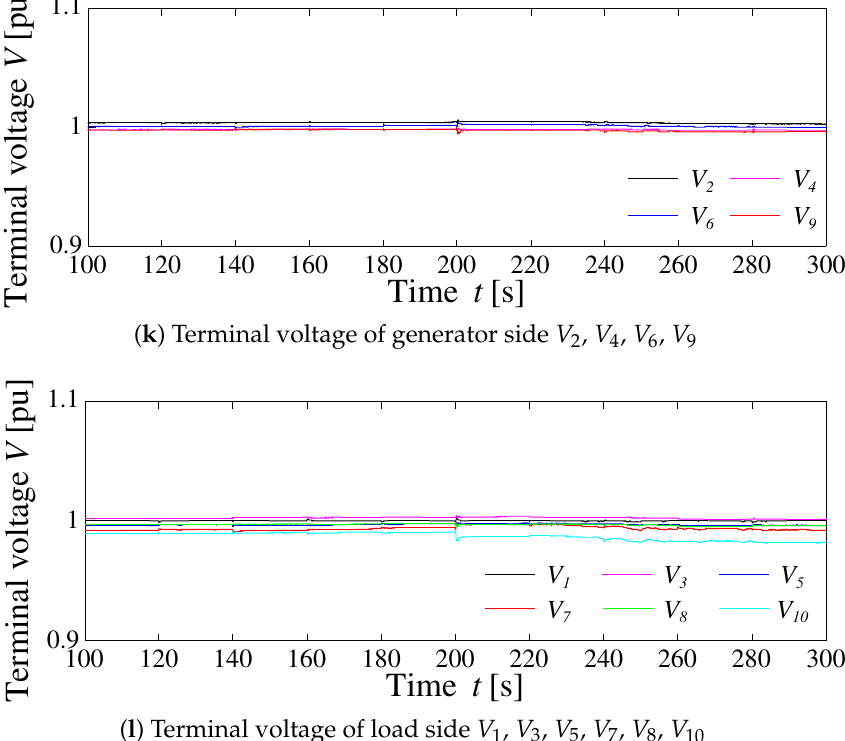
Figure 17. Simulation result (with battery and supply power suppression of renewable energy sources).